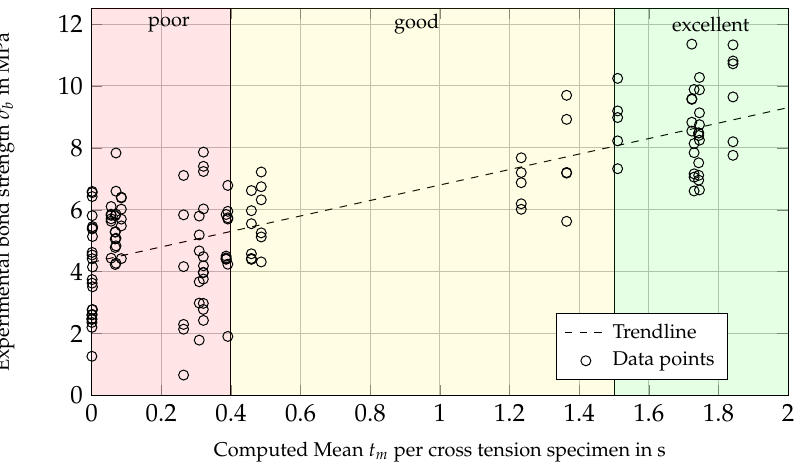
Figure 10. Correlation between experimental bond strength and computed average time period above melting temperature t m (1) at the rib